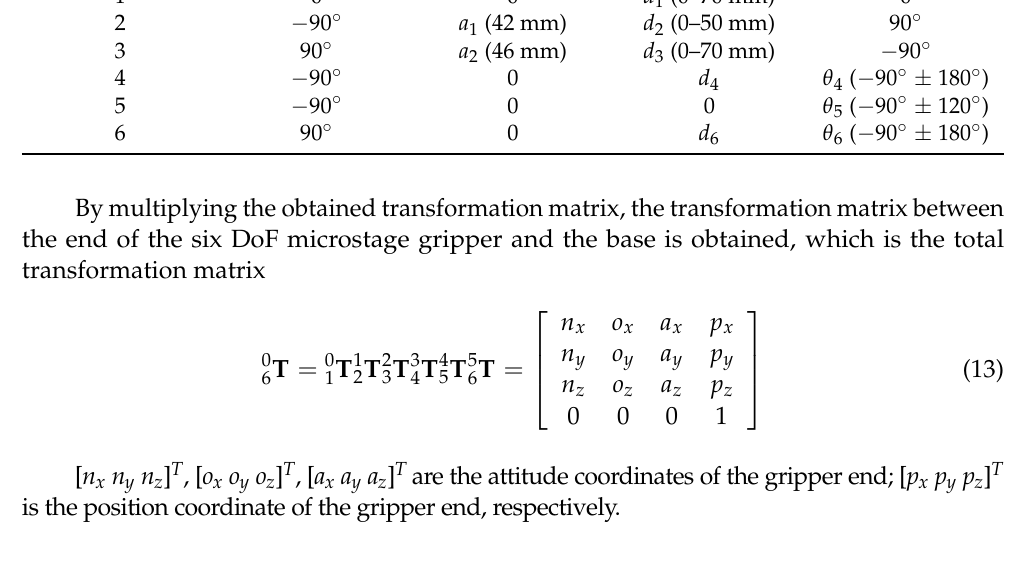
is the position coordinate of the gripper end,